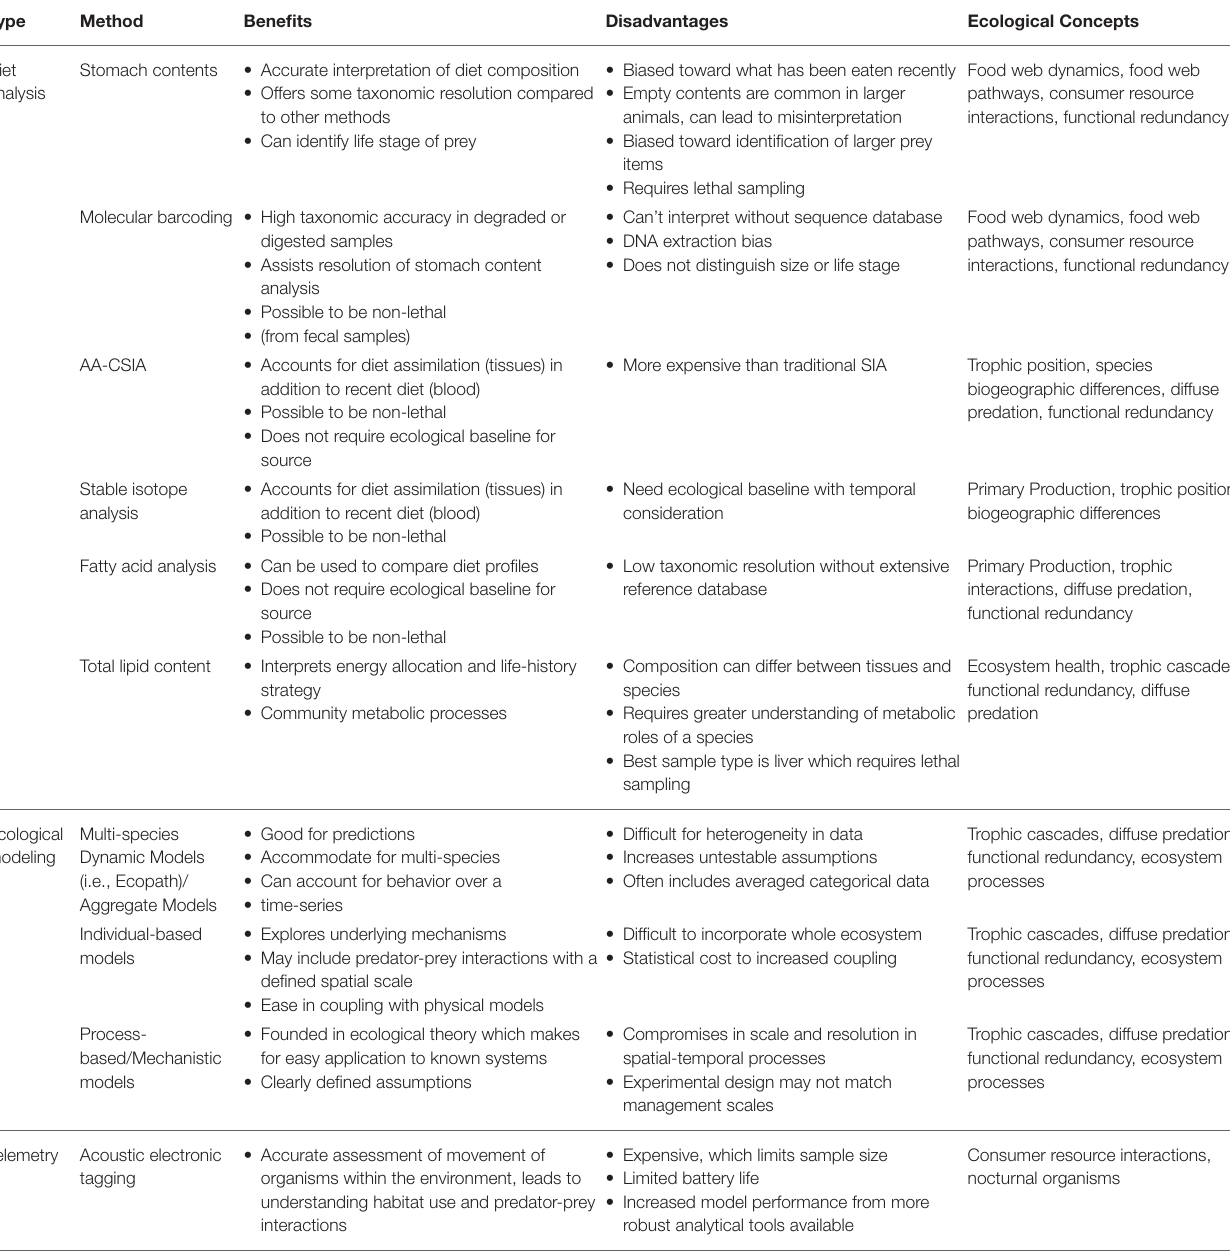
TABLE 1 | Benefits and disadvantages of methods commonly used in trophodynamic study and which ecological concepts they most relate